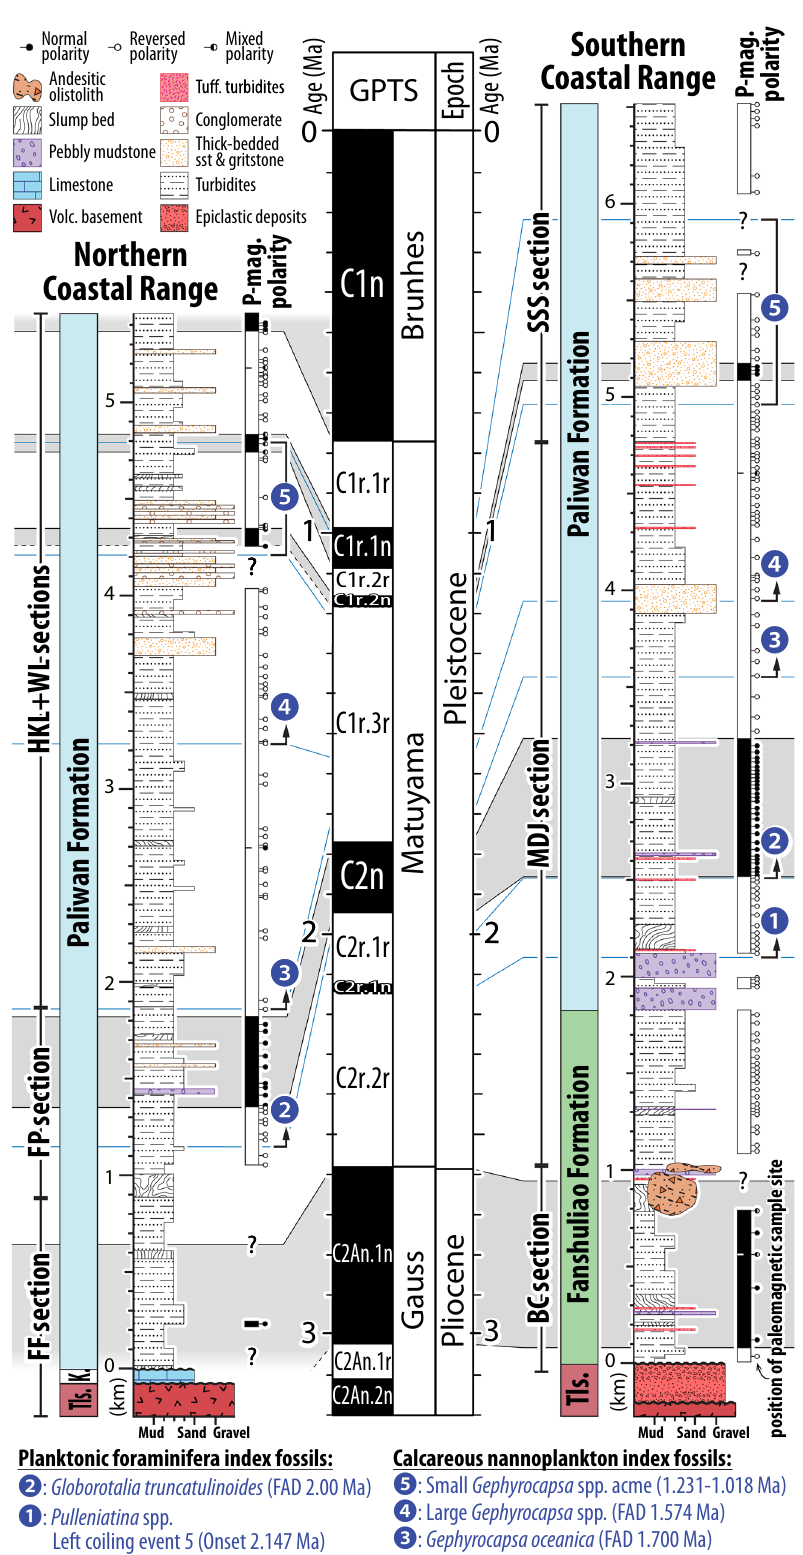
Fig. 2 Stratigraphy of the Coastal Range. Locations of studied sections are shown in Fig. 1. GPTS Geomagnetic polarity timescale. FAD First appearance datums of index microfossils. Tls Tuluanshan Formation; k Kangkou Limestone. See details of stratigraphic correlation in Supplementary Figs. 1,